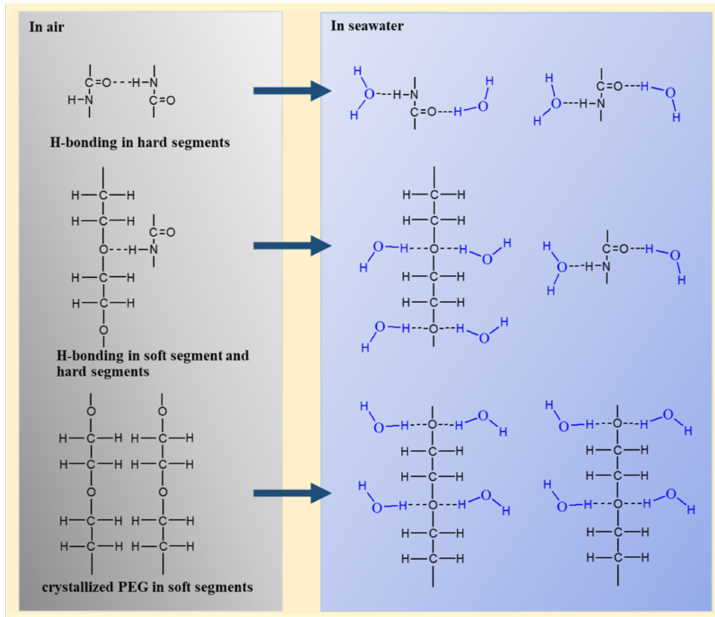
Figure 15. Schematic mechanism of interaction between coating and